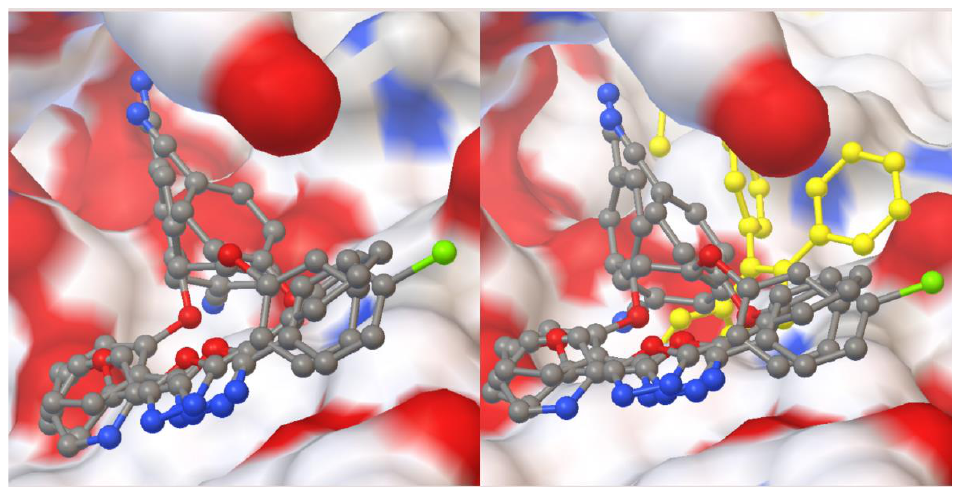
Figure 11. Superimposing poses of best scored compounds with and without reference drug tamox- ifen against breast cancer.